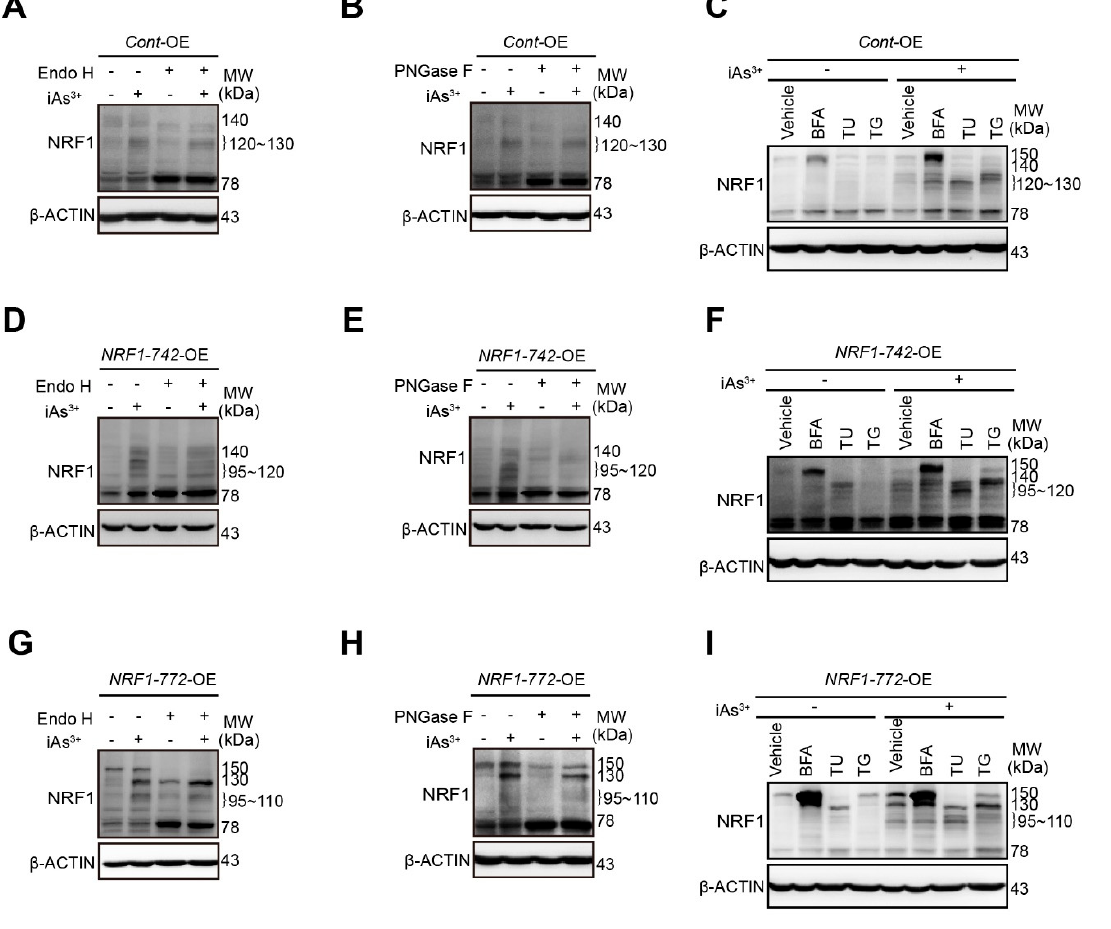
Figure 2. E ff ects of ER stressors and deglycosylase on NRF1 migration. Immunoblotting of NRF1 in whole cell lysates from Cont -OE ( A – C ), NRF1-742 -OE ( D – F ), or NRF1-772 -OE ( G – I ) cells 6 h post-treatment with the indicated agents. The doses of the agents were as follows: vehicle (0.5% DMSO), 10 µ M iAs 3 + , 2 µ g / mL Tunicamycin (TU), 1 µ g / mL Brefeldin A (BFA), or 2 µ M Thapsigargin (TG). ( A , D , G ) Samples were treated with Endo H (1000 U) at 37 ◦ C for 1 h. ( B , E , H ) PNGase F-catalyzed deglycosylation (500 U) was performed for 1 h at 37 ◦ C. Immunoblotting was performed with NRF1 and β -actin antibodies. Quantification of the NRF1 bands after deglycosylase treatment is shown in the Supplementary Materials (Figure S2).